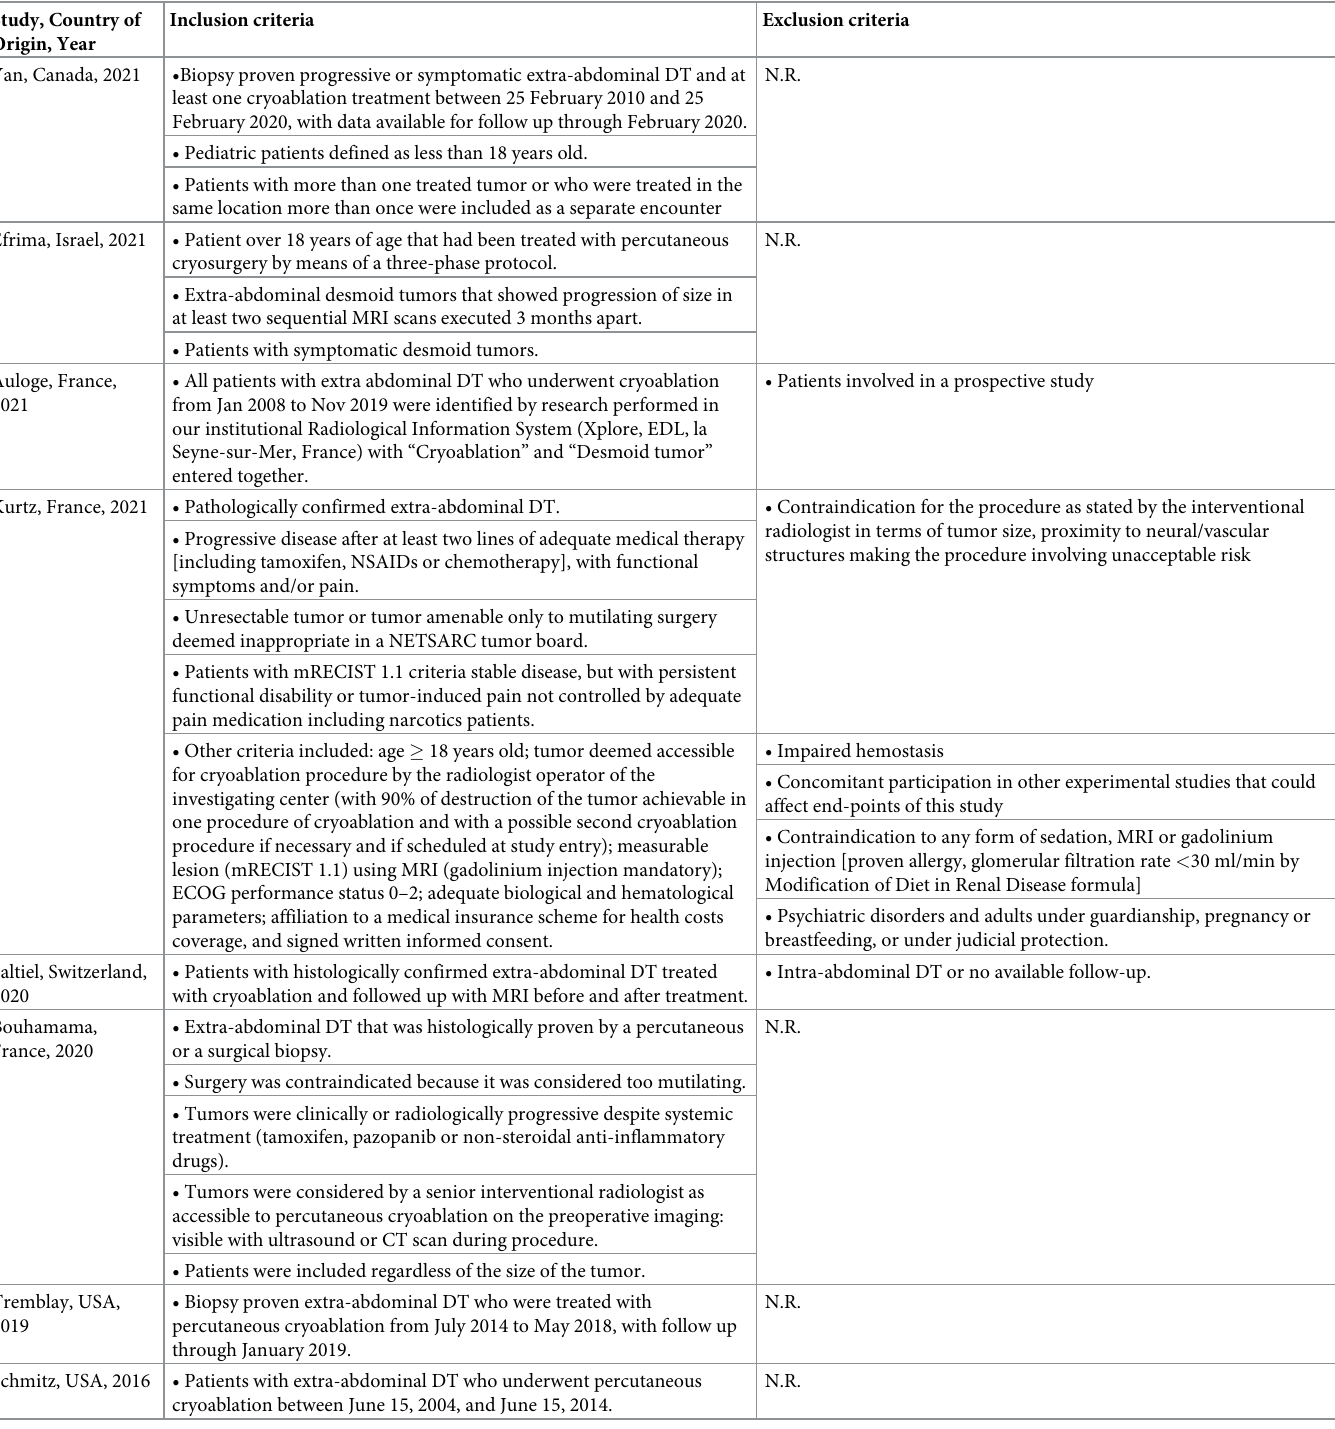
Table 1. Inclusion and exclusion criteria reported by each included